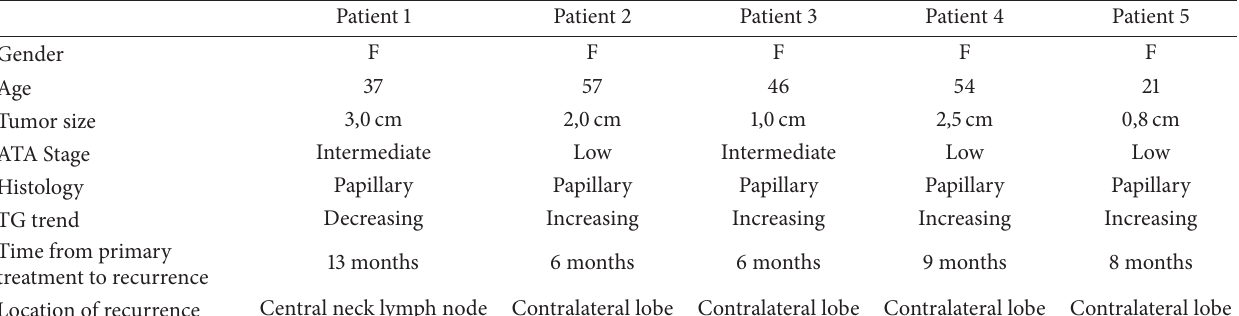
Table 2: Patients that had recurrent disease.